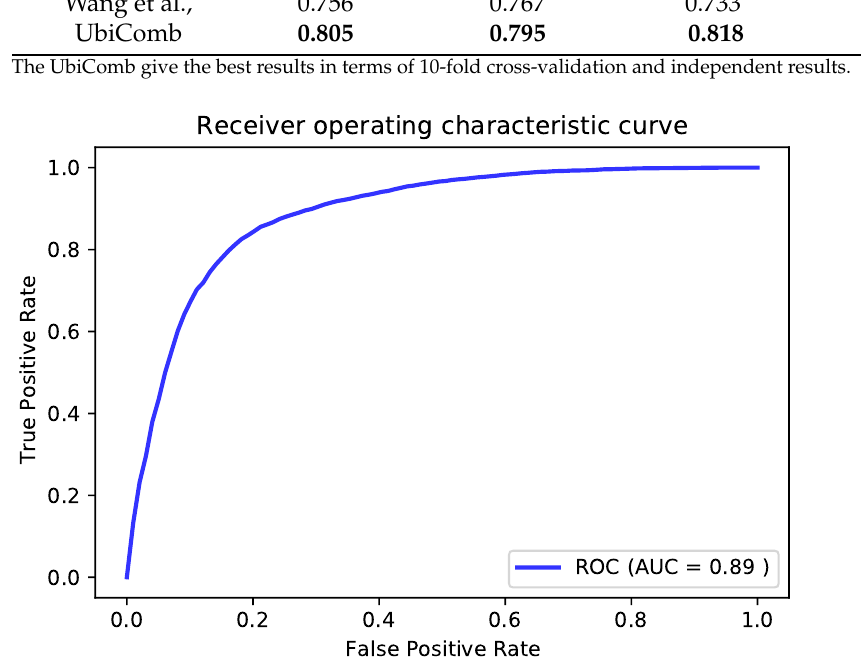
Figure 6. AUC of independent